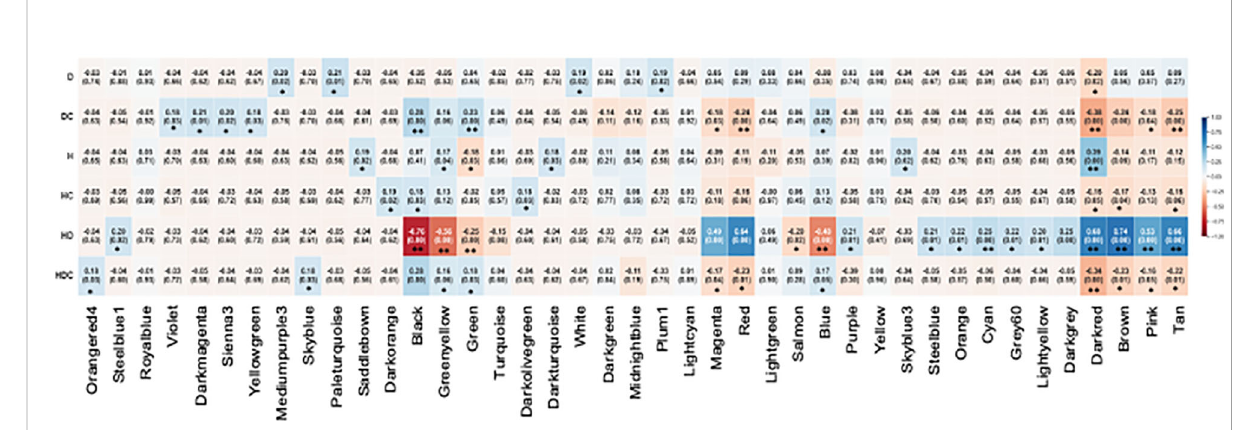
FIGURE 9 Matrix showing Module-Trait Relationships (MTRs) of different WGCNA modules under drought (D), heat (H) and combined heat and drought stress (HD) and the corresponding control modules for drought (DC), heat (HC) and combined heat and drought (HDC). The colors represent the various modules (Supplementary Figure 2). The numbers represent Pearson correlation coef fi cients, and the p-values are in parenthesis. Positive correlation is colored in blue while negative correlation is colored in red. Statistically signi fi cant correlations are indicated by *p-value <0.05 and >0.01, **p-values